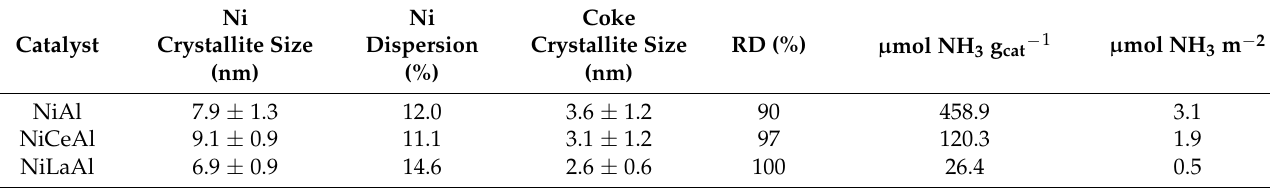
Table 2. Nickel crystallite size, nickel dispersion, coke crystallite size, reduction degree of NiO (RD), and amount of desorbed NH 3 per mass and per BET specific